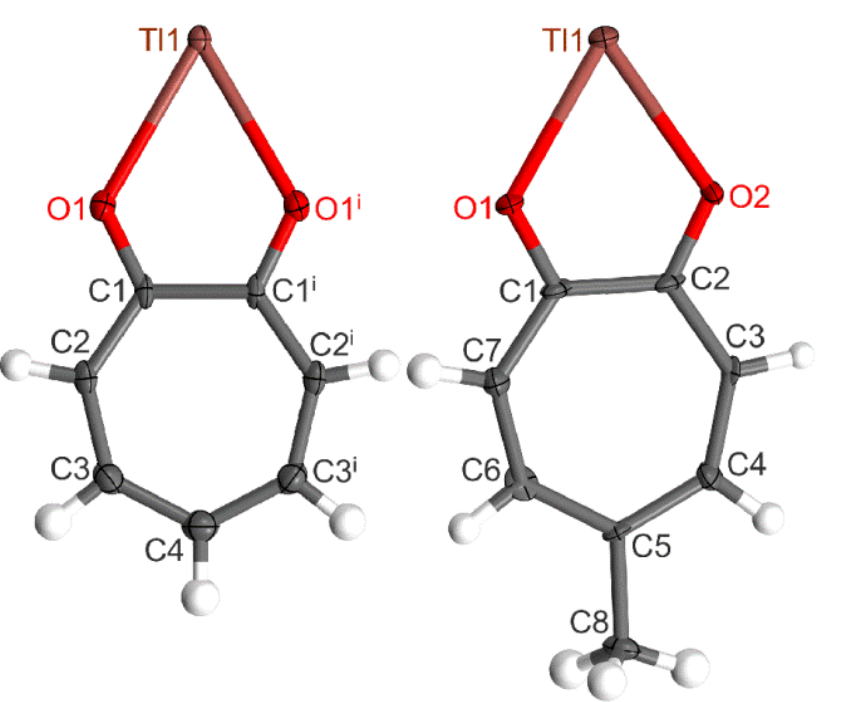
Figure 3. Molecular structures of Tl(trop) ( 1 ) (left) and Tl(5-metrop) ( 2 ) (right) (symmetry code: (i) − x + 1, y , − z + 1.5). Nonhydrogen atoms are shown as 50% ellipsoids. Table 2. Selected bond lengths, distances (Å), and angles (°) for thallium(I) chelates 1 and 2 . Bond Lengths Distances Angles